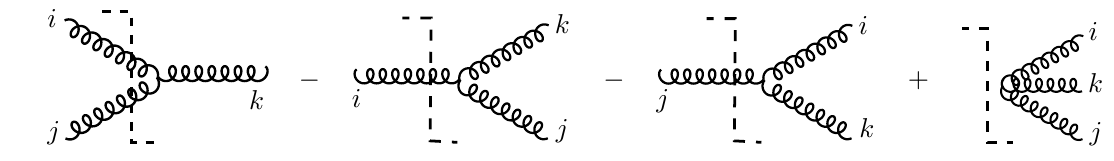
Figure 8 . A combination of real and virtual color structures allowed by